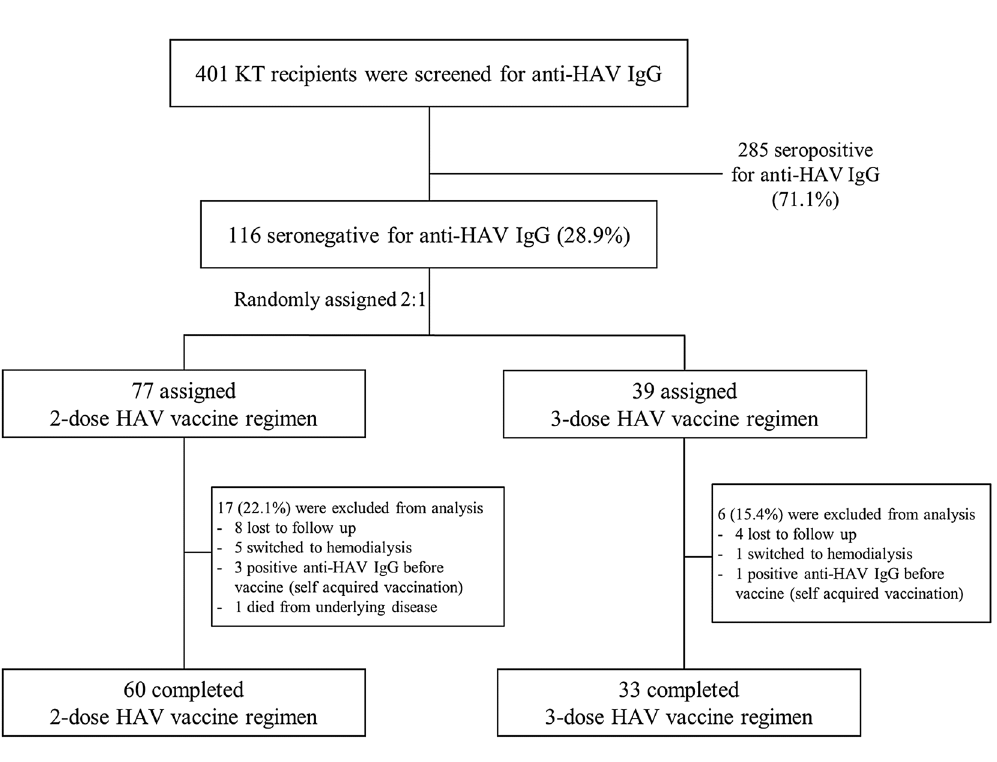
Figure 1. Enrollment and